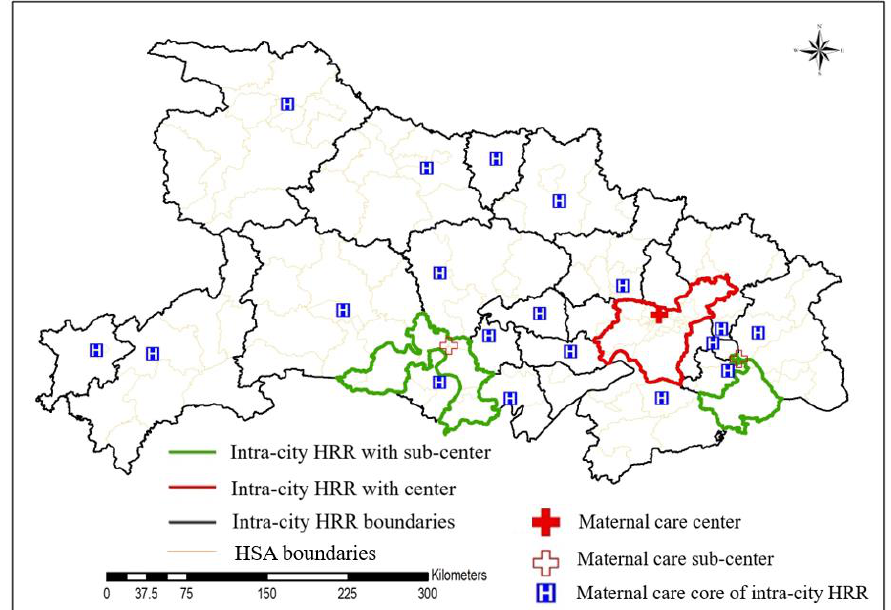
Figure 8. The distribution of maternal treatment center and subcenters.